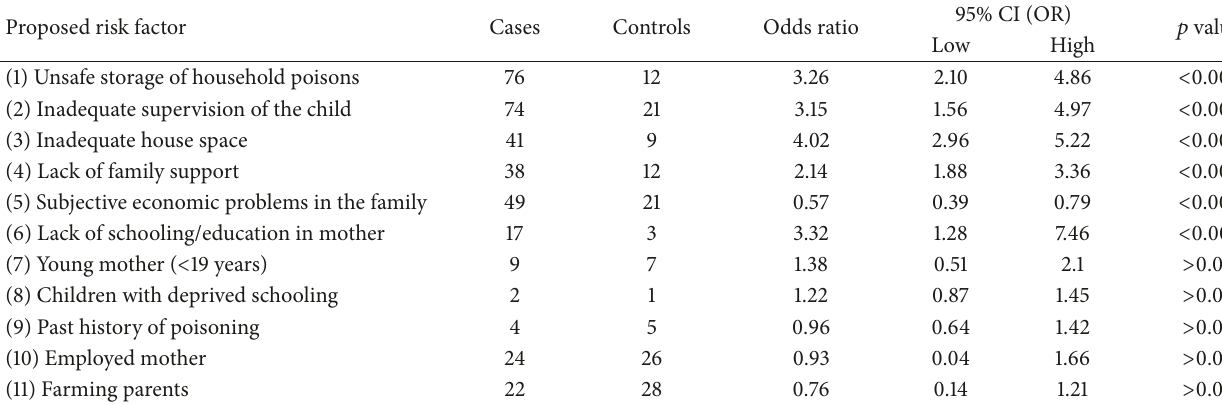
Table 4: Analysis of proposed risk factors in case-control study. Proposed risk